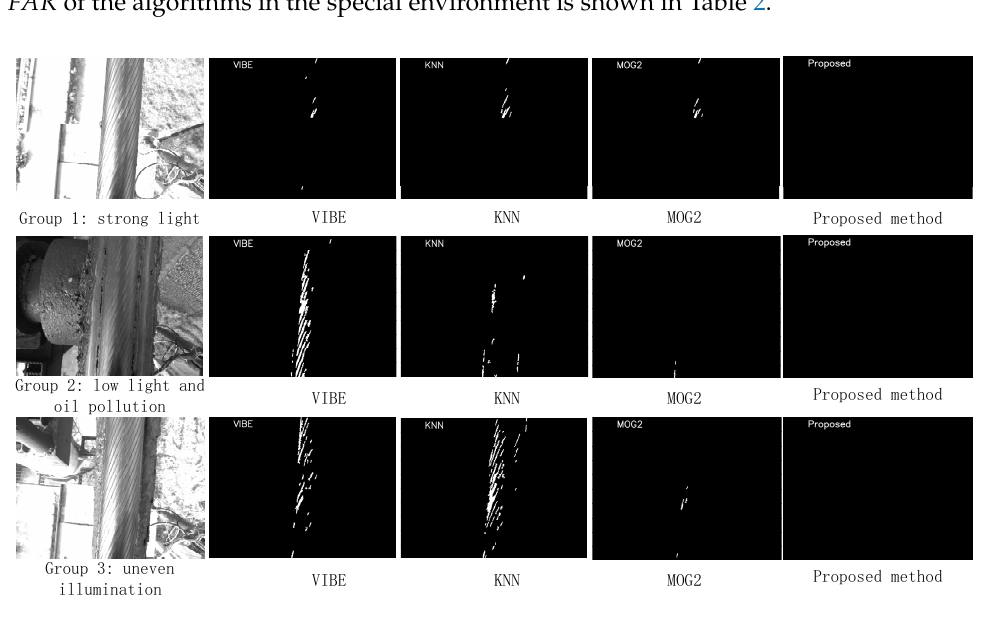
Figure 14. Detection effects of VIBE, KNN, and MOG2 and the proposed method. Table 2. 𝐹𝐴𝑅 of VIBE, KNN, MOG2, and the proposed method in the complex environment.